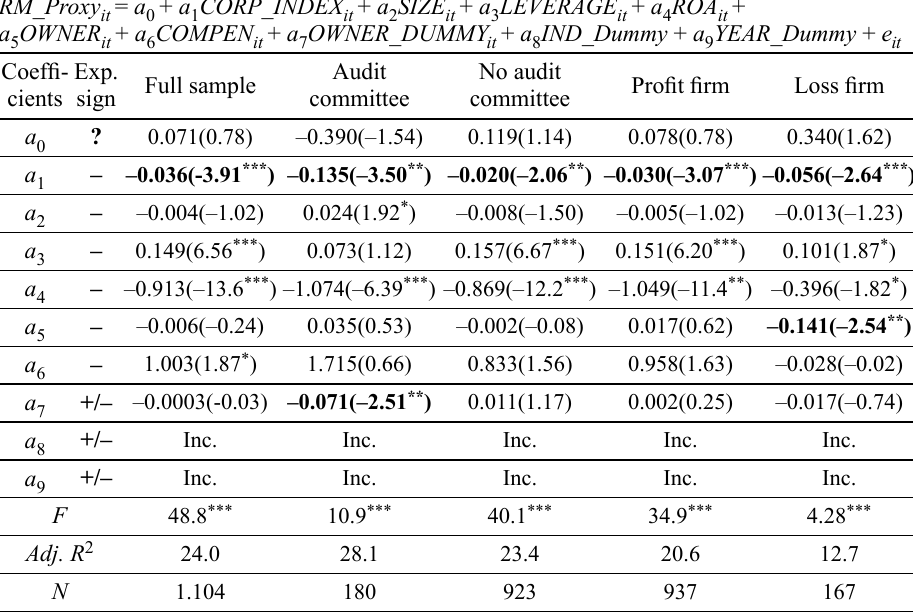
Table 5. Results of audit committee inside or loss firm Panel A: Results of using Corporate Governance